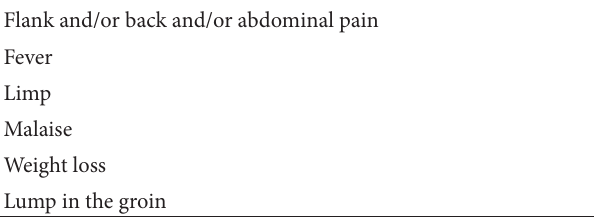
Table 3: Main clinical features of iliopsoas abscess